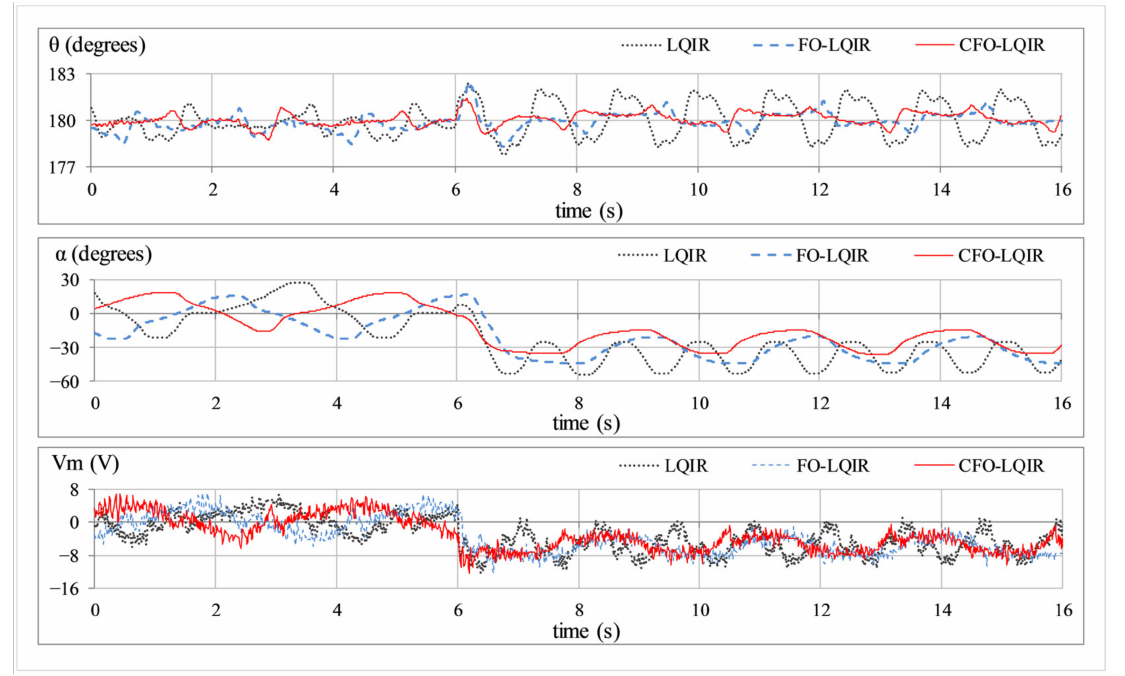
Figure 6. SRIP’s response under step disturbance.